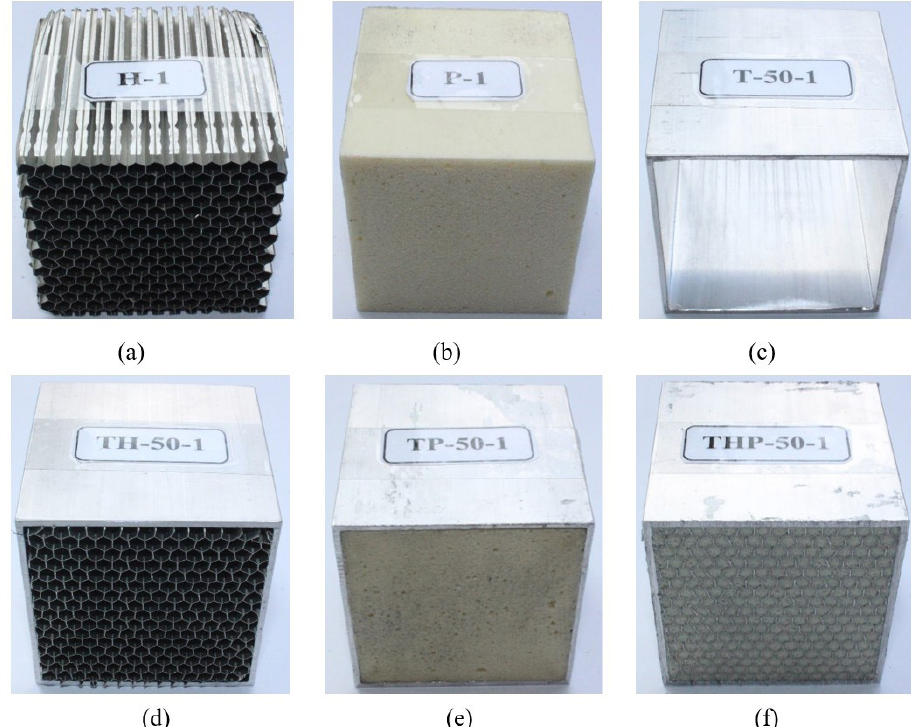
Figure 3. Photographs of typical test specimens: (a) honeycomb; (b) Pu foam; (c) empty tube; (d) tube filled with honeycomb core; (e) tube filled with Pu foam core; (f) tubes filled with mixed core (Pu foam and